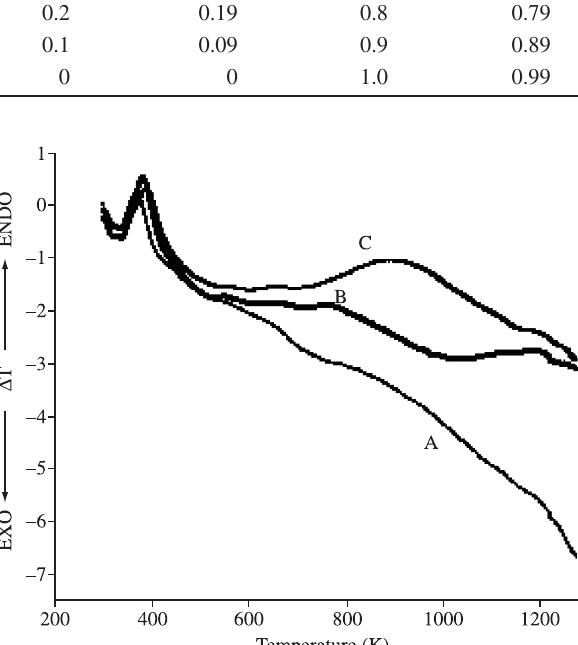
Figure 10. DTA curve for (A) Ni Zn Fe O . 1.0 2 4